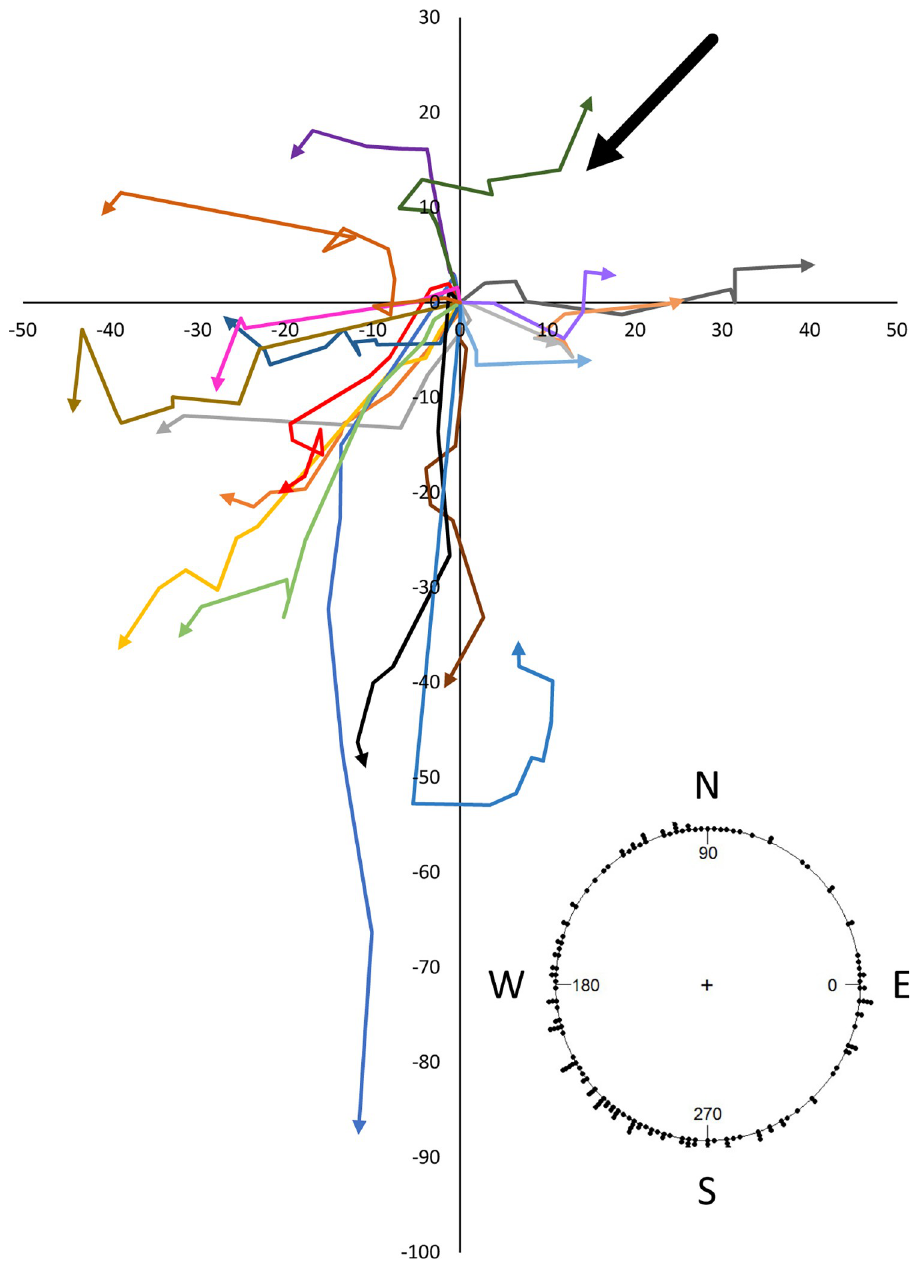
Fig 6. HR tagged Zeugodacus cucurbitae flight directions and lengths for experiment 4 (papaya field). Colored arrows represent a series of 5–10 flights for a single tagged fly. The large black arrow shows the mean wind direction for the duration of tracking. When all flights were taken together, flight directions were not homogeneous but showed directionality ( P < 0.001, Rayleigh test; P < 0.001, Hermans-Rasson test) and a unimodal distribution correlated with the mean wind direction ( P < 0.001,